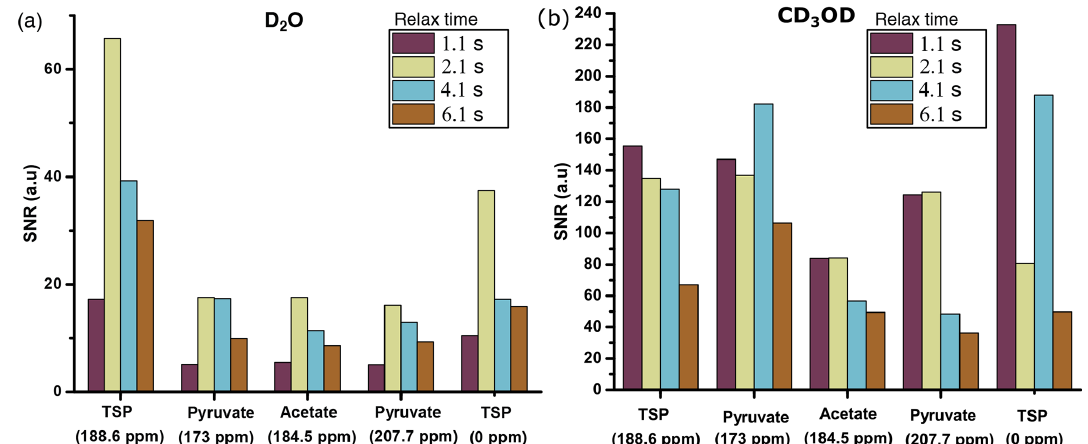
Figure 7. Sensitivity comparison of 13 C– { 1 H } signal at different relax times using (a) D 2 O and (b) CD 3 OD as dissolution solvent. The optimum relax time with D 2 O and CD 3 OD is chosen to be 2.1 and